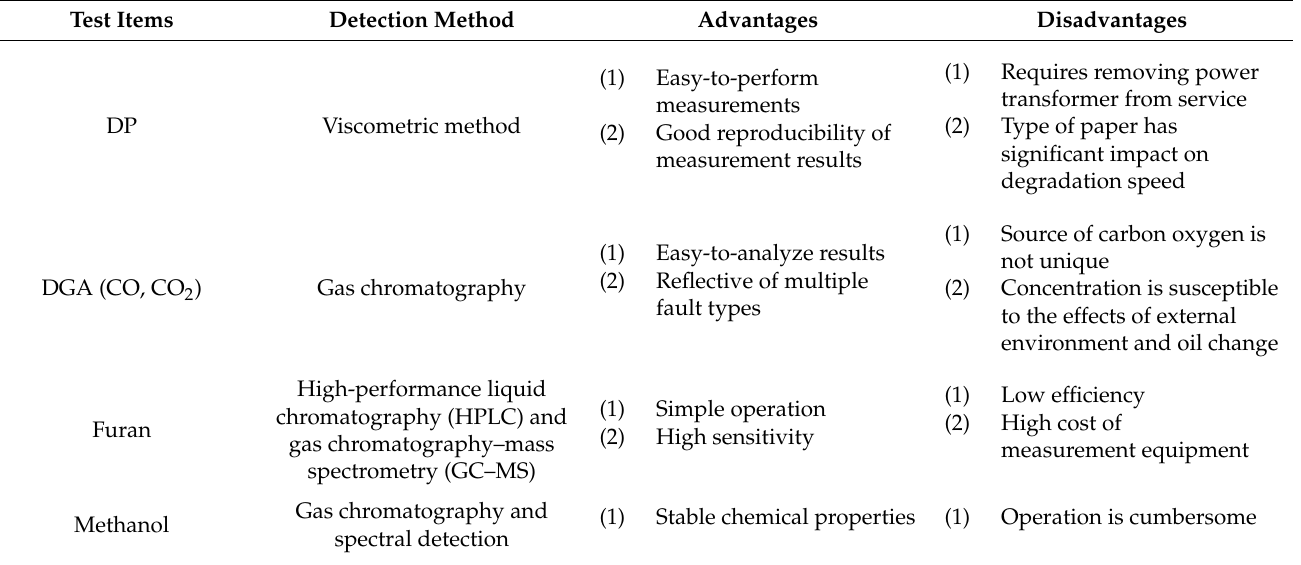
Table 1. Comparison of detection methods